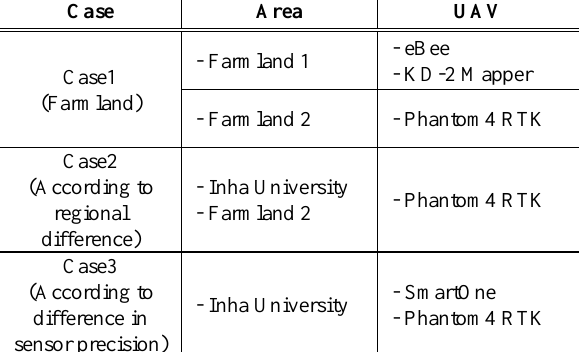
Table 2. Descriptions of the experimental cases